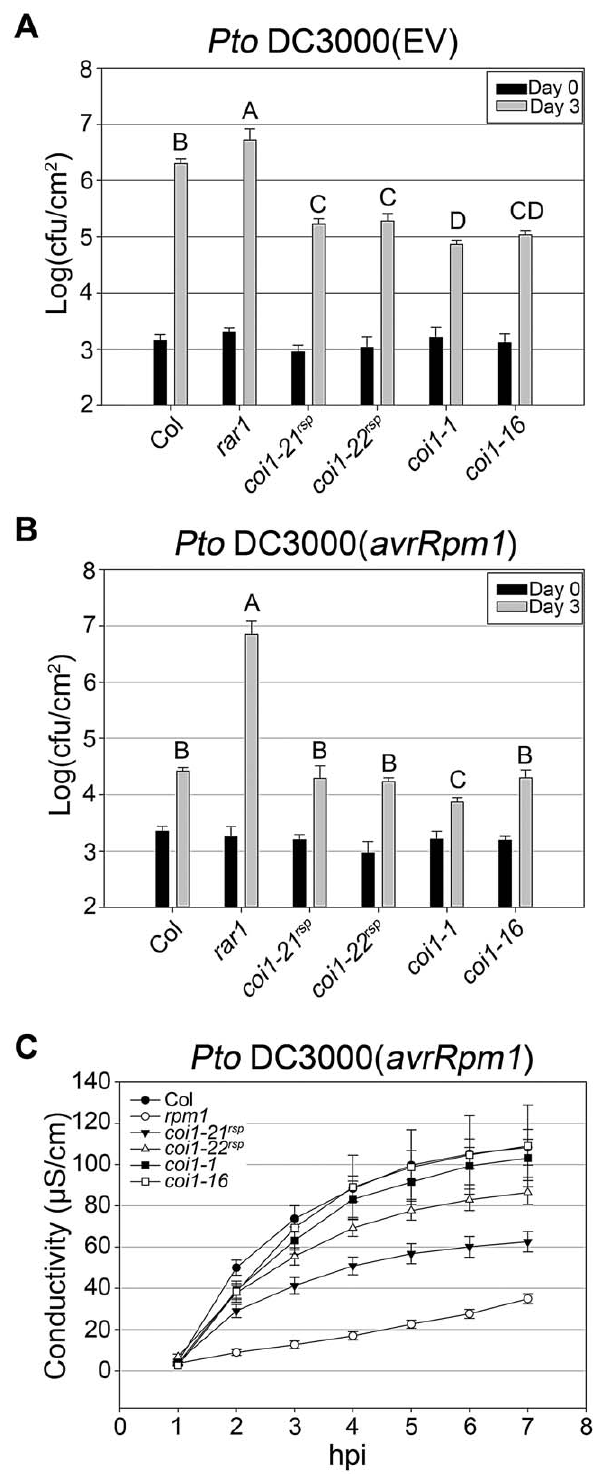
Figure 4. coi1 rsp alleles exhibit enhanced basal defense and additionally weakly suppress RPM1 HR function. (A–B) Bacterial growth analysis of Pto DC3000(EV) (A) and Pto DC3000( avrRpm1 ) (B). Bacteria were hand-infiltrated into leaves of each indicated genotype and counted at day 0 and day 3. Error bars represent 2 6 SE. Pairwise comparisons for all means for bacterial growth on day 3 were performed with One-Way ANOVA test followed by Tukey-Kramer HSD at 95% confidence limits. (C) Conductivity measurements